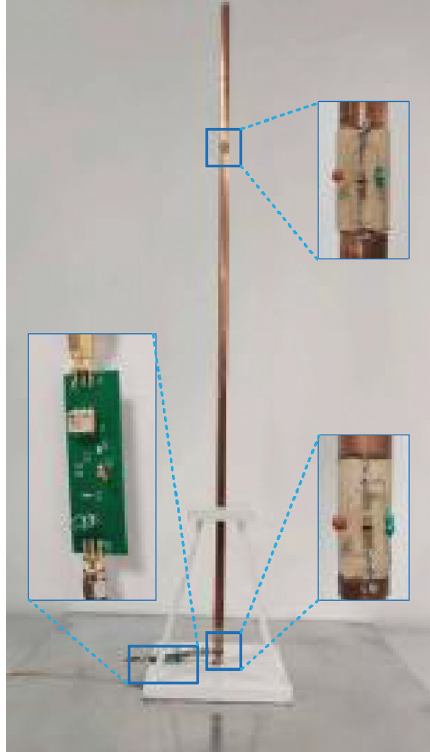
Figure 17: Scaling model of HF broadband antenna.